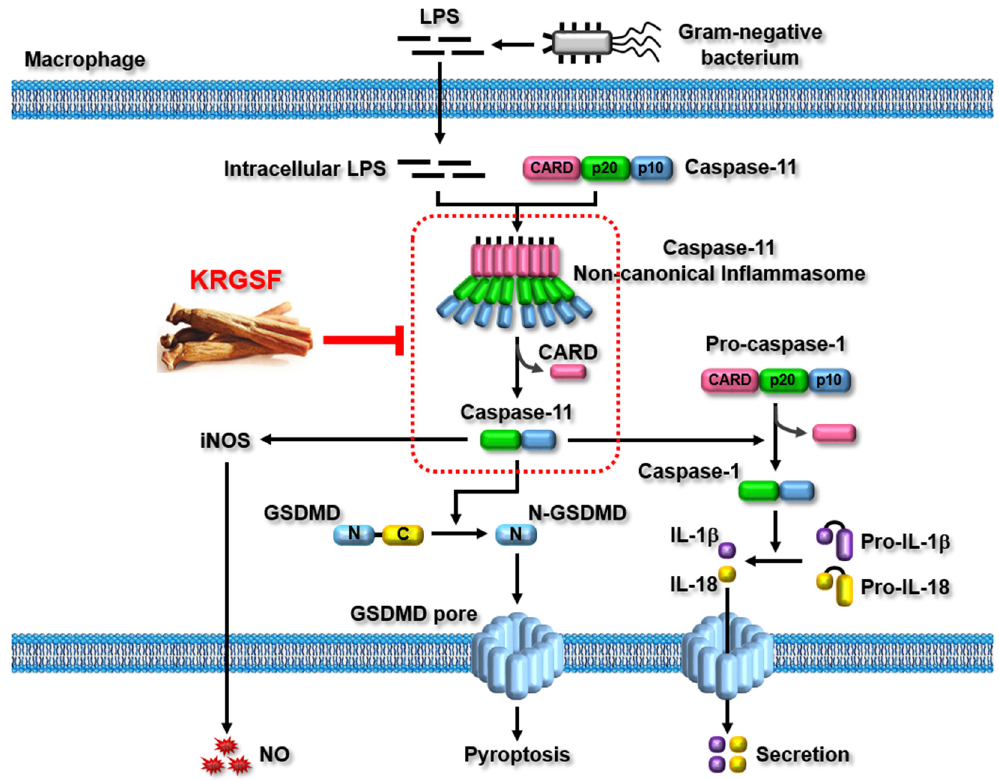
Figure 5. KRGSF-suppressed anti-inflammatory role in the activation of caspase-11 non-canonical inflammasome in macrophages.